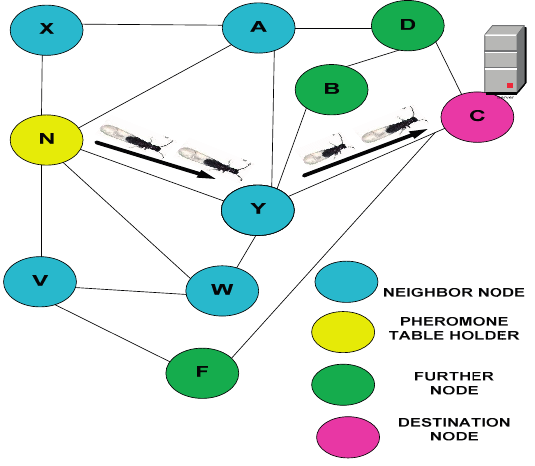
Figure 6. Routing process of the pheromone termite